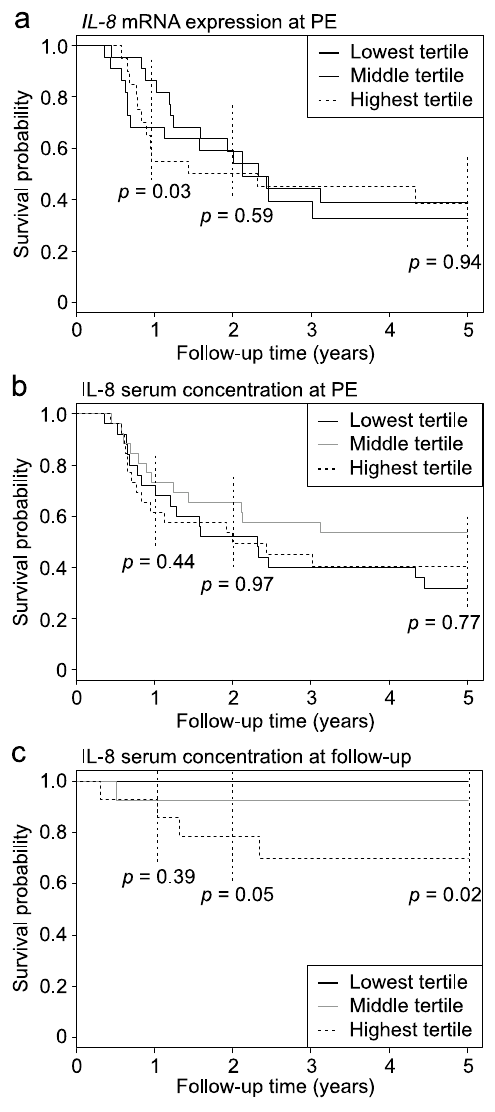
Figure 4. Native liver survival according to tertiles for IL-8 expression. Kaplan–Meier survival curves for native liver survival according to tertiles of ( a ) liver IL-8 mRNA expression at portoenterostomy (PE) ( n = 64), ( b ) serum IL-8 concentration at PE ( n = 77), and ( c ) serum IL-8 concentration measured at the first follow-up sample ( n = 40).